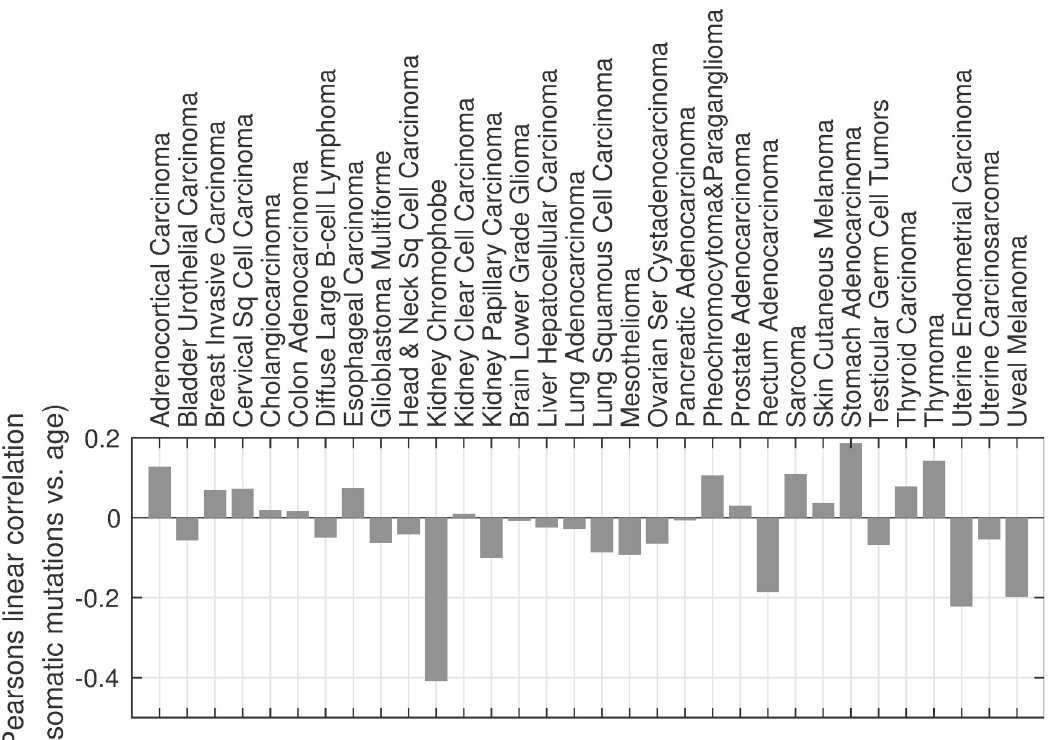
Fig 2. Somatic mutations at diagnosis are weakly correlated with age at cancer diagnosis. Pearson’s linear correlation between somatic mutations and age at diagnosis ranges from -0.2 to +0.2, except for kidney chromophobe for which there were only nine matched tumor and blood derived normal